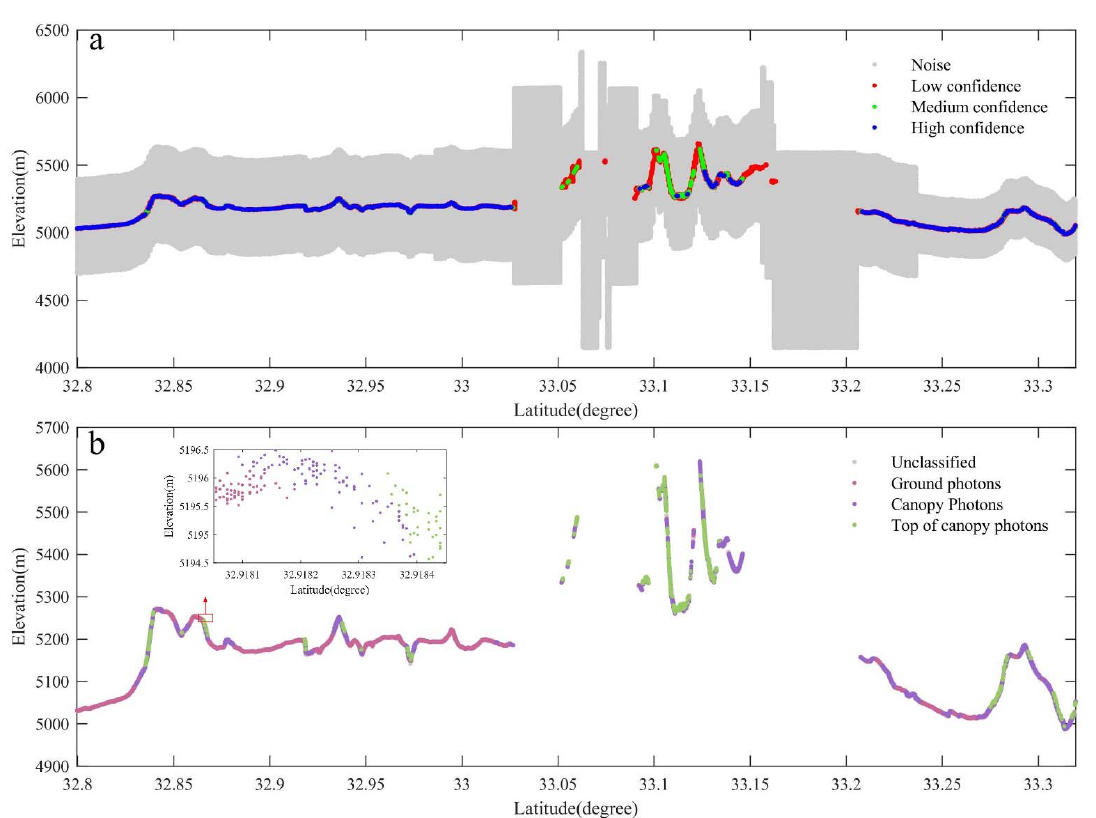
Figure 4. ATL03 photon section view: ( a ) shows the ATL03 data classified by the signal_conf_ph parameter, ( b ) shows the result of the joint classification of ATL03 and ATL08 data with medium and high confidence.